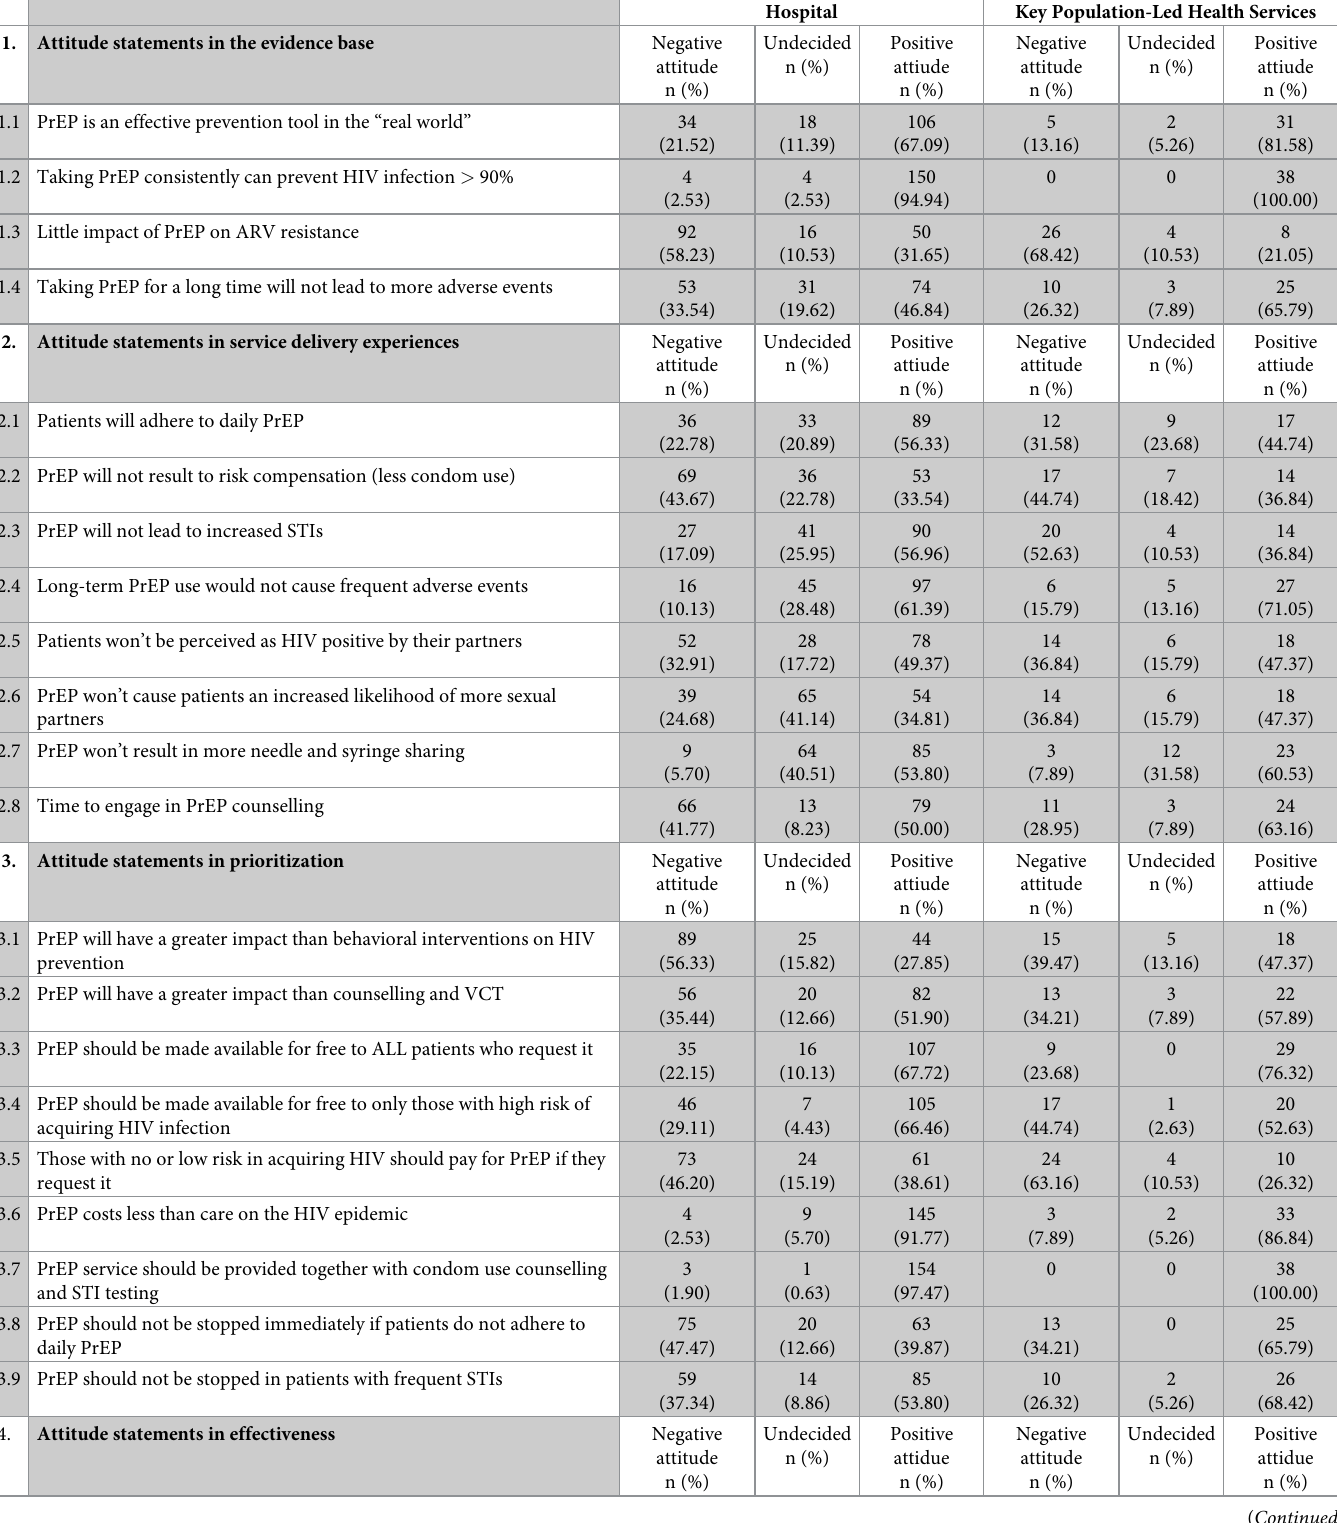
Table 3. Hospital and Key Population-Led Health Services providers’ attitudes towards